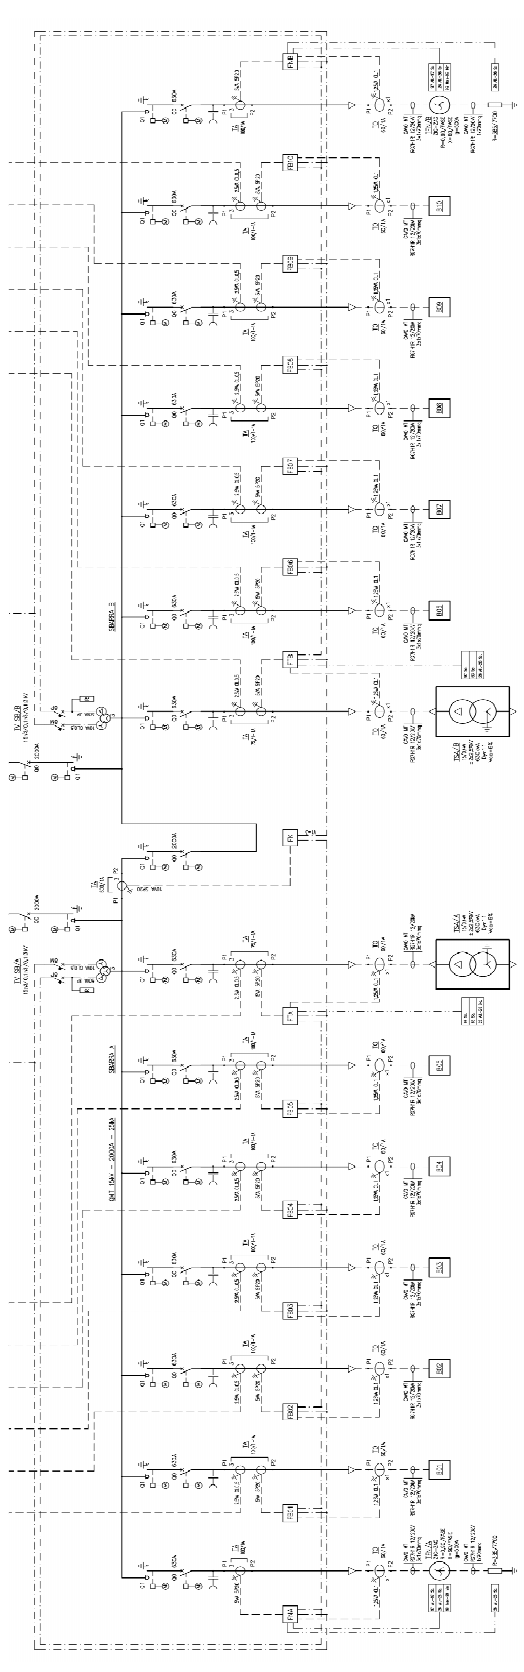
Figure 4. Single-line diagram of Italian “power intensive” installation (Storage Lab) in Codrongianos.